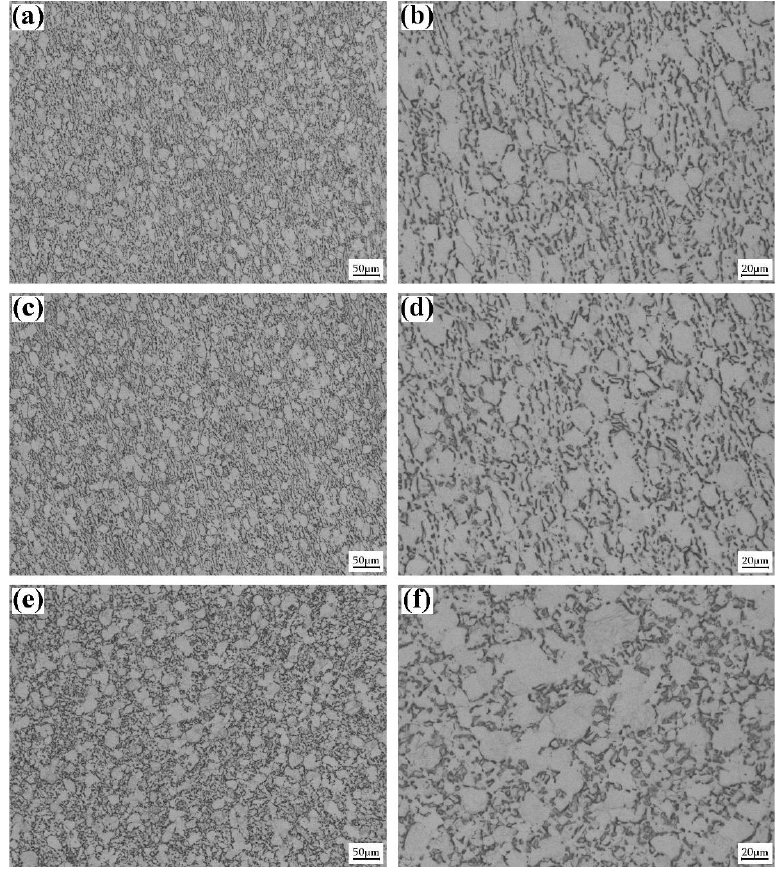
Figure 3. Optical micrographs of the mill-annealed Ti-6Al-4V alloy plate after the strain-limited ( ε = 10%) dynamic compression test. ( a , b ) Strain-limited RD specimen; ( c , d ) strain-limited TD speci- men; ( e , f ) strain-limited ND specimen.